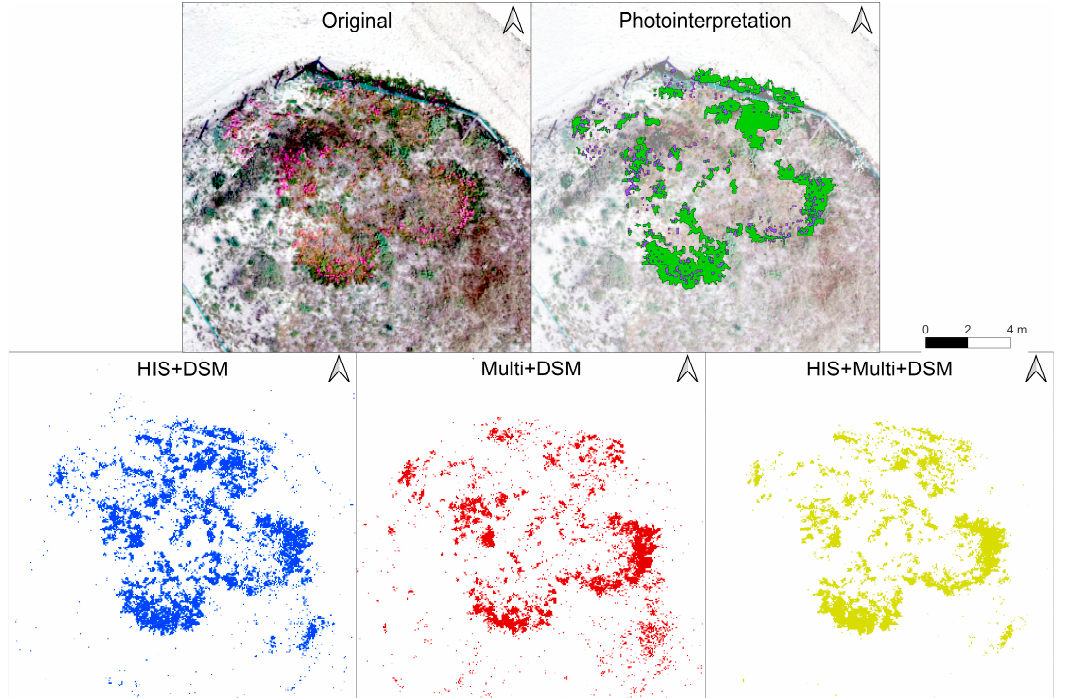
Figure 6. Example image showing results of the prediction of total Carpobrotus using the intermediate training area (30%) and the datasets HIS + DSM, Multi + DSM, and HIS + Multi + DSM. All images have the same scale, while the different colours are used only to aid visualization. The original orthomosaic at 5 cm resolution is shown in the top left, while the manual photointerpretation is visible in the top right. The figure shows a typical Carpobrotus patch surrounded by bare sand and other dune vegetation. Compared with the original RGB mosaic and manual photointerpretation, several parts of the image were misinterpreted as Carpobrotus , especially by the models based on HIS + DSM and Multi + DSM, while HIS + Multi + DSM retained the overall shape of the Carpobrotus patch. In terms of variable importance (Figure 7), when using HIS + DSM data, intensity (INT) was the most important variable in predicting both Total and Green parts, while saturation (SAT) was predominant for Flowers. Concerning the Multi + DSM dataset, the importance of the variables was comparable between the different parts of the plant, with GNDVI marginally more important than SAVI. Finally, for the more complex dataset, HIS + Multi + DSM, intensity, saturation and GNDVI each contributed 1/5 of the importance of the overall variables in the case of Total and Green parts, while GNDVI was more relevant in the case of Flowers. Although DSM was the only variable included in all models, its importance was always marginal, exceeding 25% only in the case of Flowers in Multi +